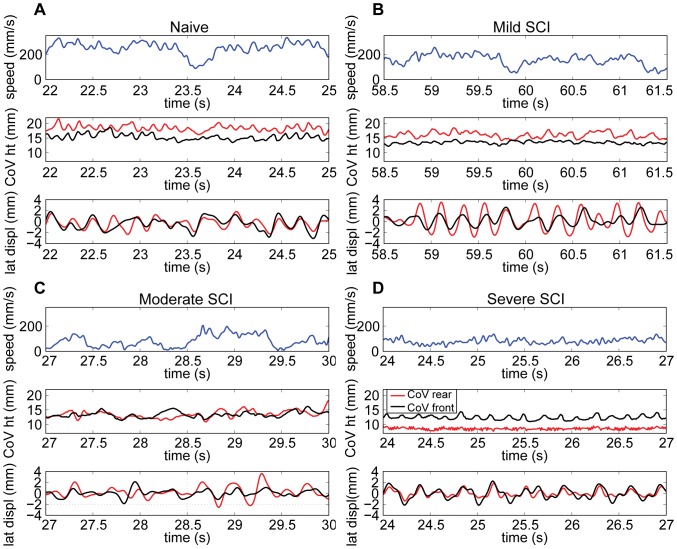
An animal’s locomotion speed, CoV heights and lateral displacements reflect motor SCI severity.Locomotion speed, height of the rear CoV (red) and front CoV (black) and lateral displacement of the rear and front CoV for a representative A) Naïve B) Mild SCI C) Moderate SCI D) Severe SCI animal.